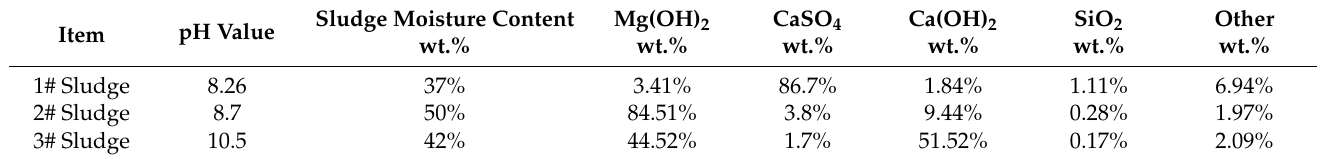
Table 3. Compositions of the sludge after chemical dosing process.